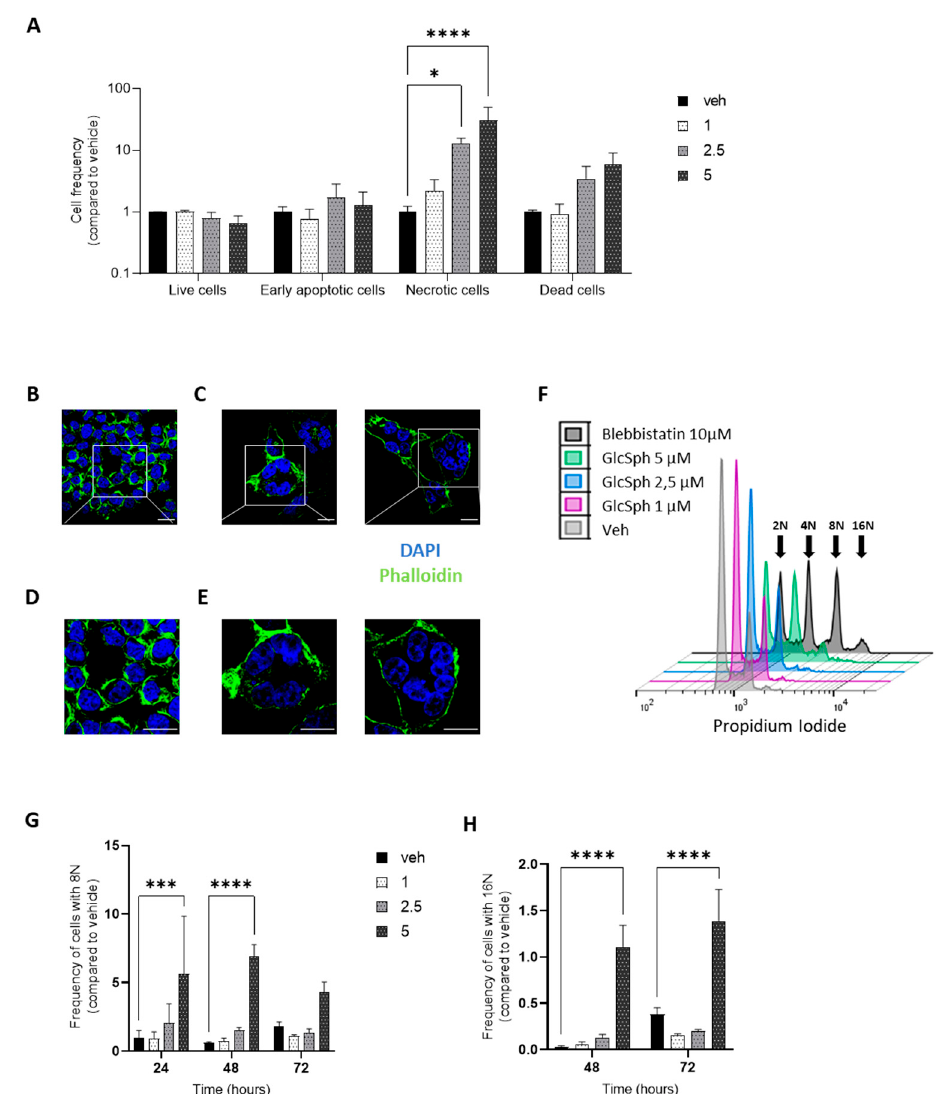
Figure 4. GlcSph induces necrosis and produces multinucleated cells in A375 human melanoma cells. ( A ) A375 cells were treated for 24 h with either different concentrations of GlcSph (1, 2.5, and 5 µ M) or with ethanol (veh), stained with Annexin V-FITC and 7-AAD, and analyzed by flow cytometry; 20,000 events were recorded and sorted as follows: live cells (Annexin V-negative/7-AAD-negative), dead cells (Annexin V-positive/7-AAD-positive), early apoptosis (Annexin V-positive/7-AAD-negative), and necrosis (Annexin V-negative/7-AAD-positive). Histograms represent the cell frequency of GlcSph-treated cells compared to vehicle-treated cells. ( B – E ) A375 cells were treated for 48 h with ethanol ( B , D ) or GlcSph 5 µ M (C and E), fixed and stained with phalloidin (for F-actin, green), and nuclei were counterstained with DAPI (for DNA, blue). Then, they were imaged by confocal microscopy (Zeiss) at 63 × ( B , C ), with an additional upper zoom ( × 2) of the selected regions (white square) ( D , E ). Scale bar = 20 µ m. ( F – H ) A375 cells were incubated either with different concentrations of GlcSph (1, 2.5, or 5 µM) or with ethanol (veh) for 24, 48, and 72 h. Then, cells were stained with propidium iodide (PI) and analyzed by flow cytometry. Figure ( F ) is a representative plot of cell cycle analysis of GlcSph- and vehicle-treated A375 cells for 48 h. To identify the peaks corresponding to abnormal ploidies, A375 cells were treated with blebbistatin (10 µM), a myosin II inhibitor (see arrows). The proportion of cells with 8N ( G ) and 16N ( H ) in GlcSph-treated cells compared to controls was quantified. For experiments in A, G, and H, data are expressed as means +/ − SEM of three independent experiments. Statistical significance was determined by a two-way mixed ANOVA. *, p < 0.05; ***, p < 0.001; ****, p < 0.0001 compared to vehicle-treated cells.